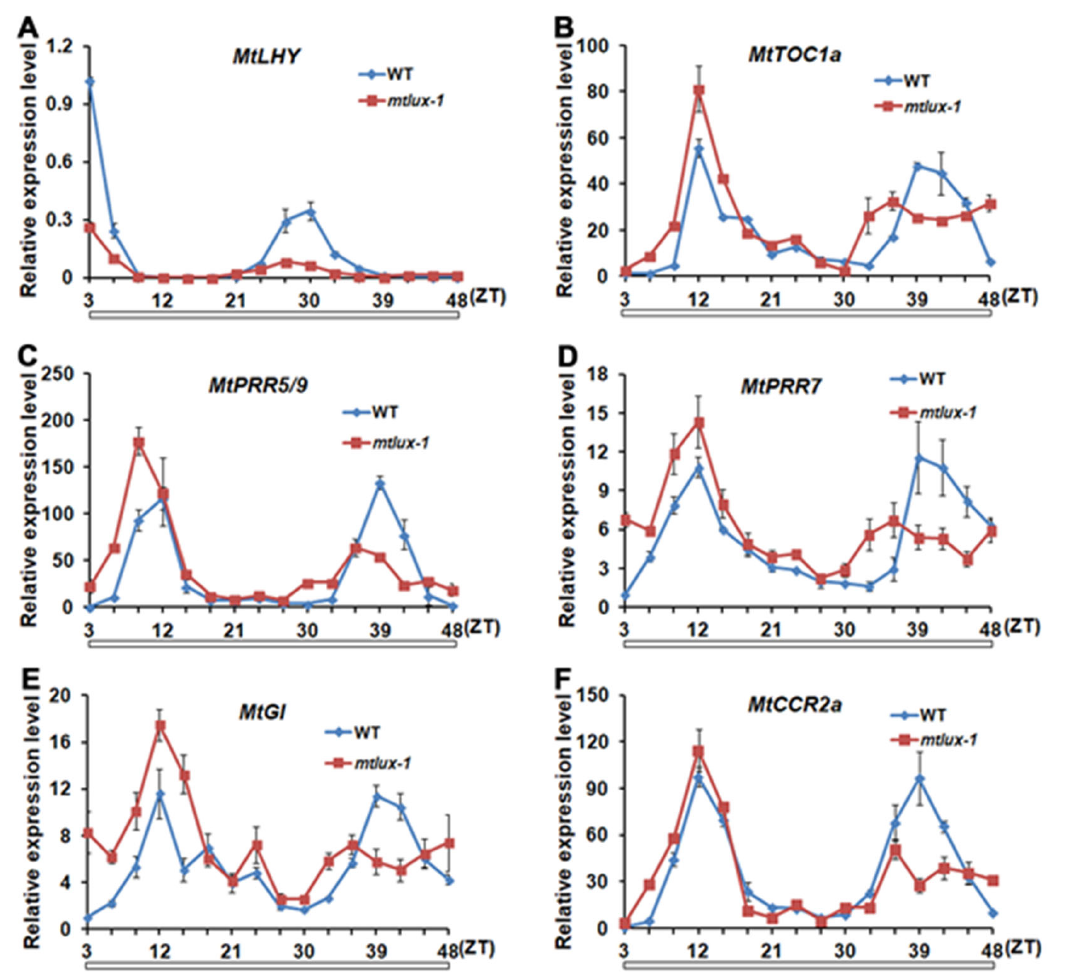
Figure 4. Regulation of MtLUX on circadian expression of clock genes in continuous light. The transcriptional behaviors of MtLHY ( A ), MtTOC1a ( B ), MtPRR5/9 ( C ), MtPRR7 ( D ), MtGI ( E ), and MtCCR2a ( F ) in the leaves of 4-week-old WT and mtlux-1 plants grown under constant light conditions. Values are shown as means ± SD of three biological replicates. White bars at the bottom indicate periods of constant light.